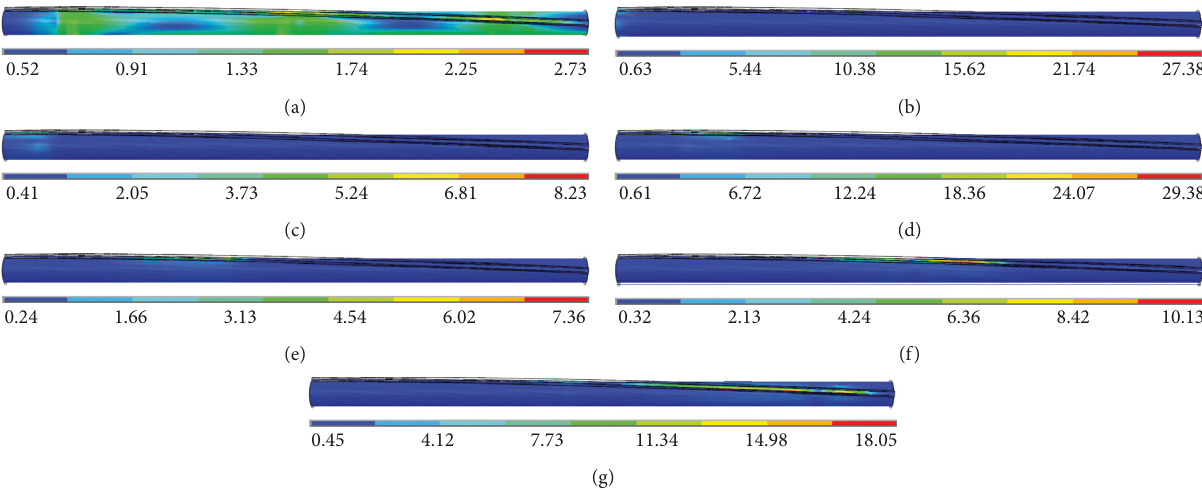
Figure 8: von Mises stress distribution of the inner surface under dynamic pressure in different time periods. (a) 30ms. (b) 40 ms. (c)